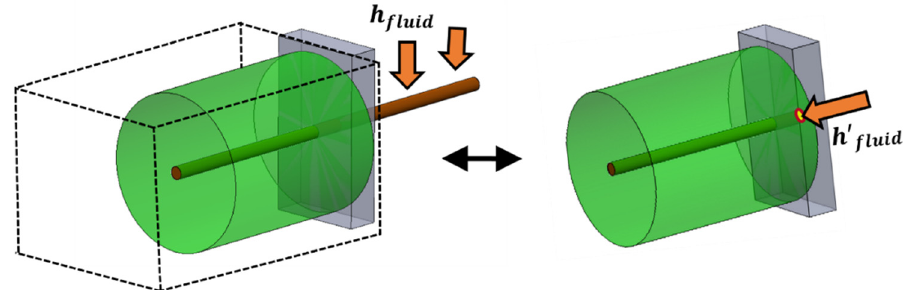
Figure 9. Simplification of the computational domain of single PCM ‐ wire domain.